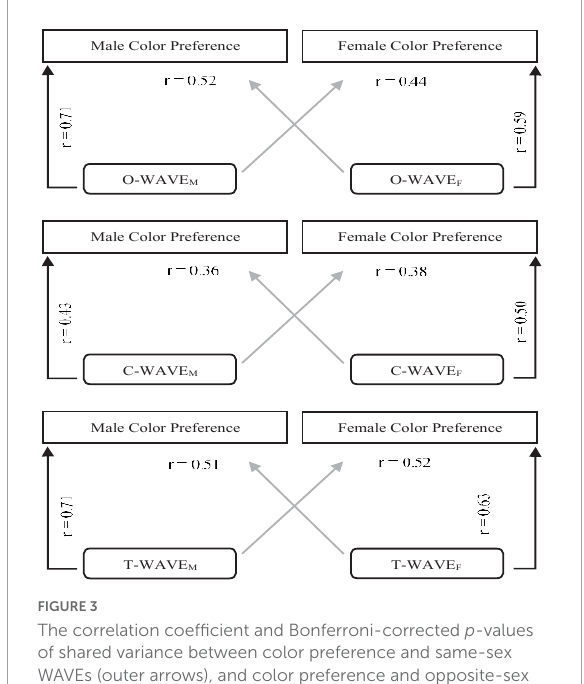
FIGURE3 The correlation coefficient and Bonferroni-corrected p -values of shared variance between color preference and same-sex WAVEs (outer arrows), and color preference and opposite-sex WAVEs (inner diagonal arrows), for the three WAVE types (O-WAVE, C-WAVE, and T-WAVE).